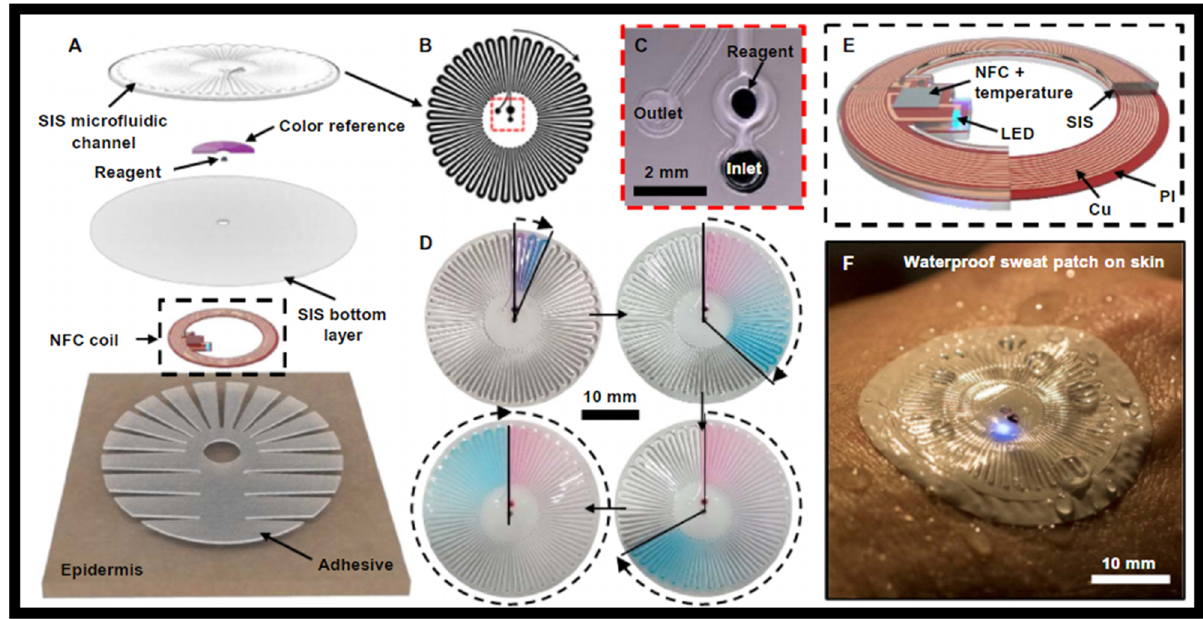
Figure 11. Skin-like microfluidic/electronic device that is waterproof, ( A ) schematic depiction of the major layers of a typical device [147], ( B ) geometry of microfluidic channels [147], ( C ) optical micrograph of the colorimetric reagent and microfluidic intake and outflow ports [147], ( D ) a flow- driven color shift is produced by a dye made up of blue and red water-soluble particles that dissolve at different speeds. The total volume of collected perspiration is calculated by counting the number of turns of filled tubes [147], ( E ) NFC coil for wireless evaluations of skin temperature [147], ( F ) sweat gathering in aquatic environments without contamination is supported by small outlet geometries and constituent polymer materials that are hydrophobic and largely impermeable to water and water vapor. Underwater functioning of the electronics, containing the NFC coil, integrated circuit chip, and indicator LED, is supported by dip-coating an encapsulation of the same material